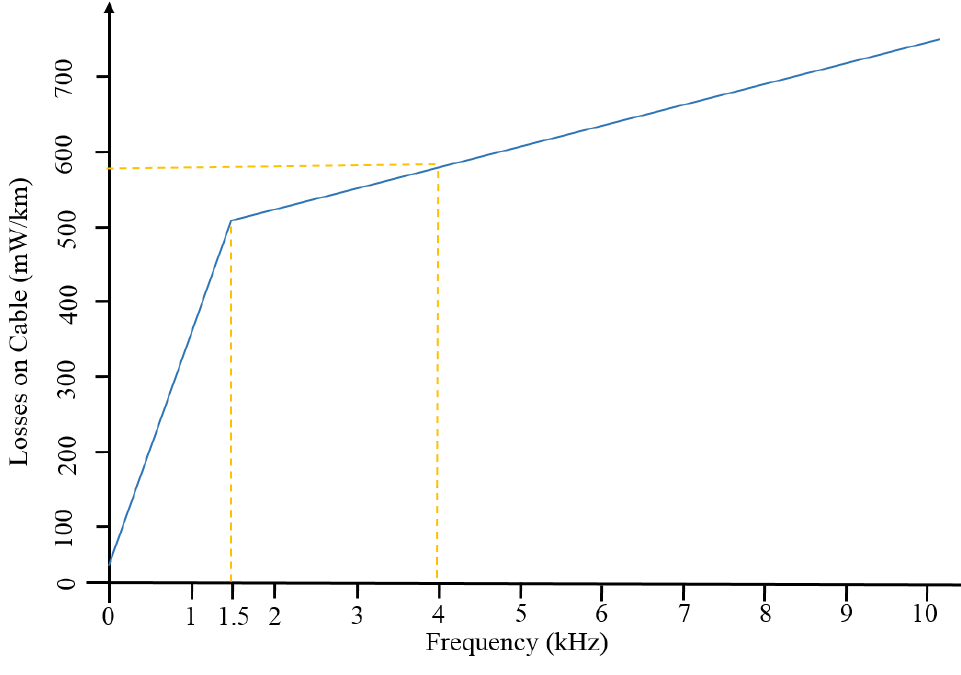
Figure A1. Cable losses at a range of frequencies with AC current magnitude of 1A at each fre- quency